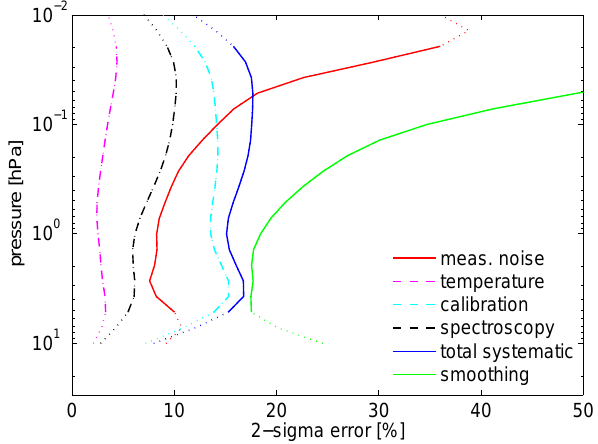
Fig. 13. Estimated 2- σ errors in the retrieved profile resulting from different families of